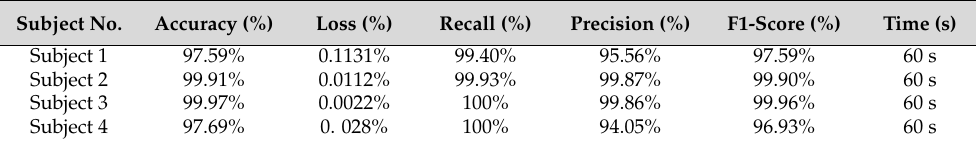
Table 8. Performance Evaluation (Different Datasets with Full